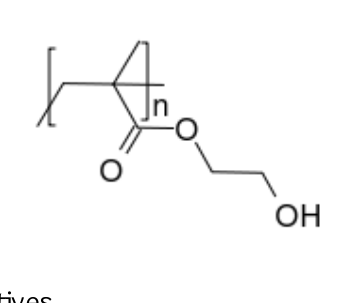
Figure 7. Chemical structure of